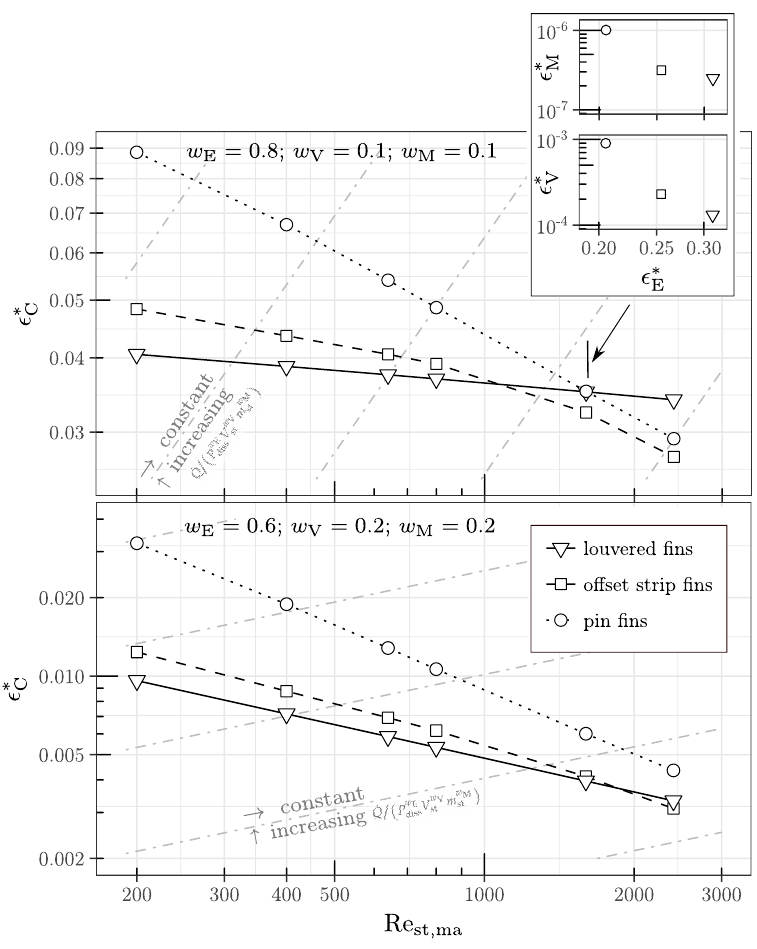
Figure 9. Combined efficiency (cid:101) ∗ dash-dot lines represent combinations of (cid:101) ∗ the data points are additionally shown in an (cid:101) ∗